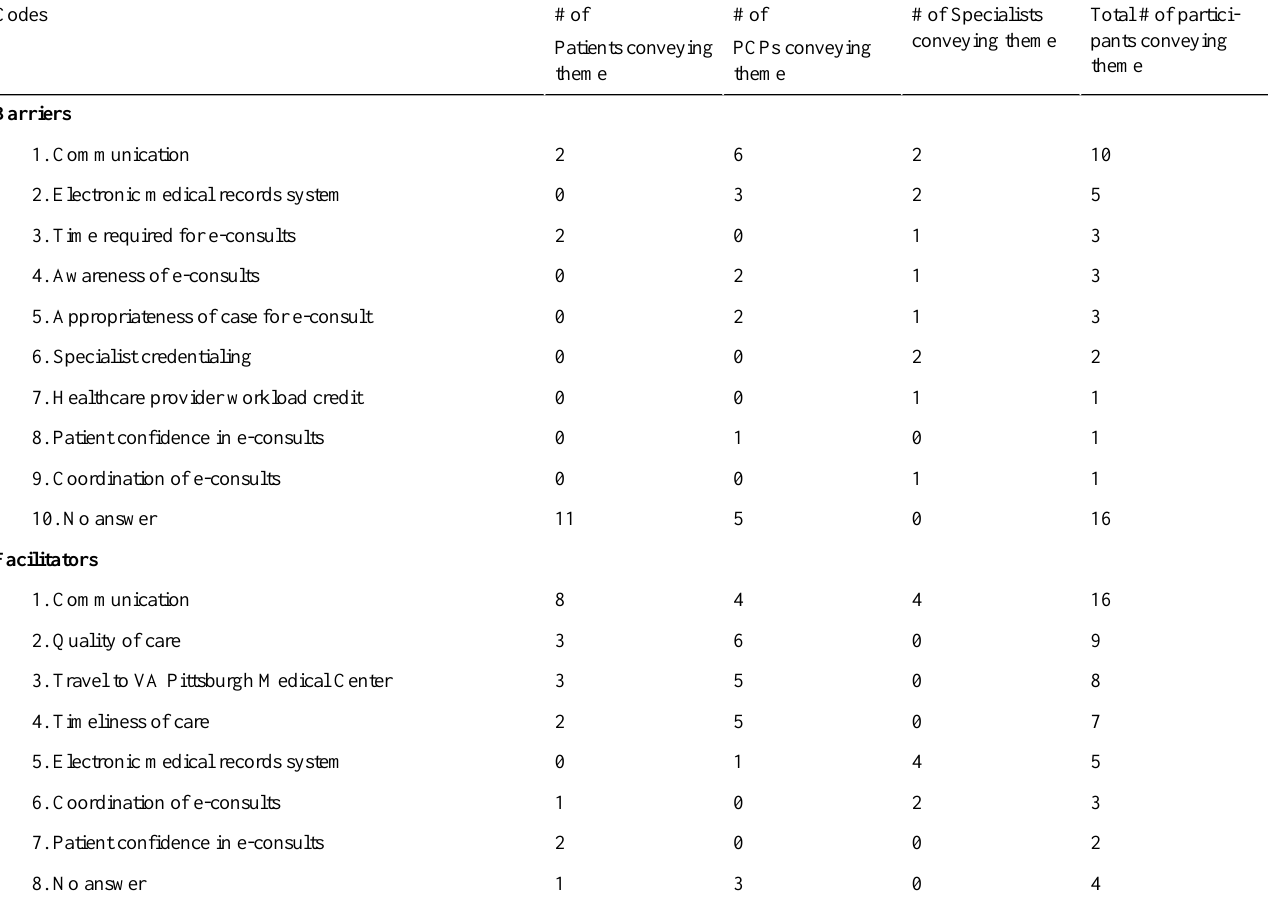
Table 4. Codes and frequencies for perceived barriers and facilitators to e-consultation utilization identified during interviews with 15 patients, 15 PCPs, and 4 specialty physicians who utilized the e-consult process.